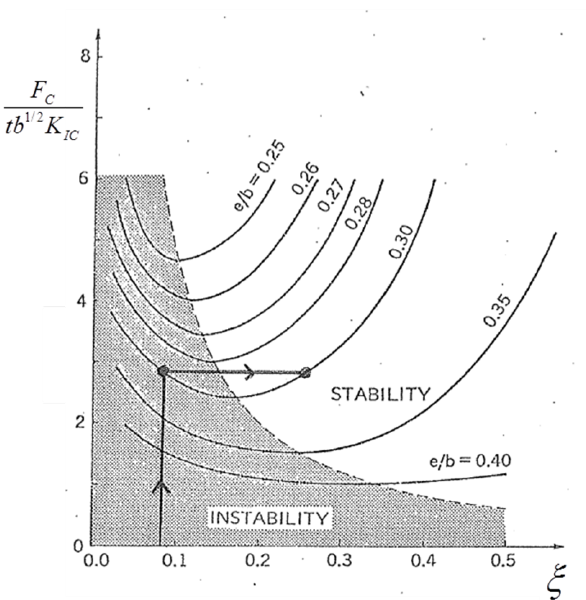
Figure 11: Fracturing process for off-center